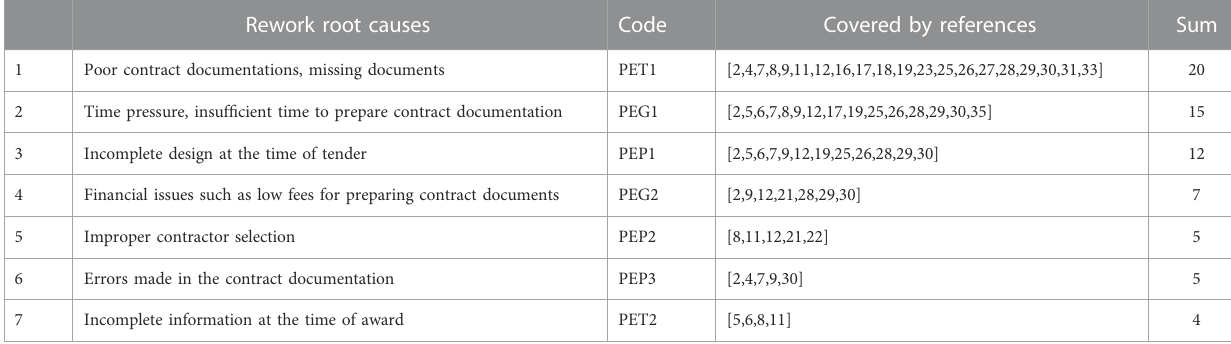
TABLE 4 Rework causes classi fi cation in procurement stage — liable to the client-side of the contract. Rework root causes